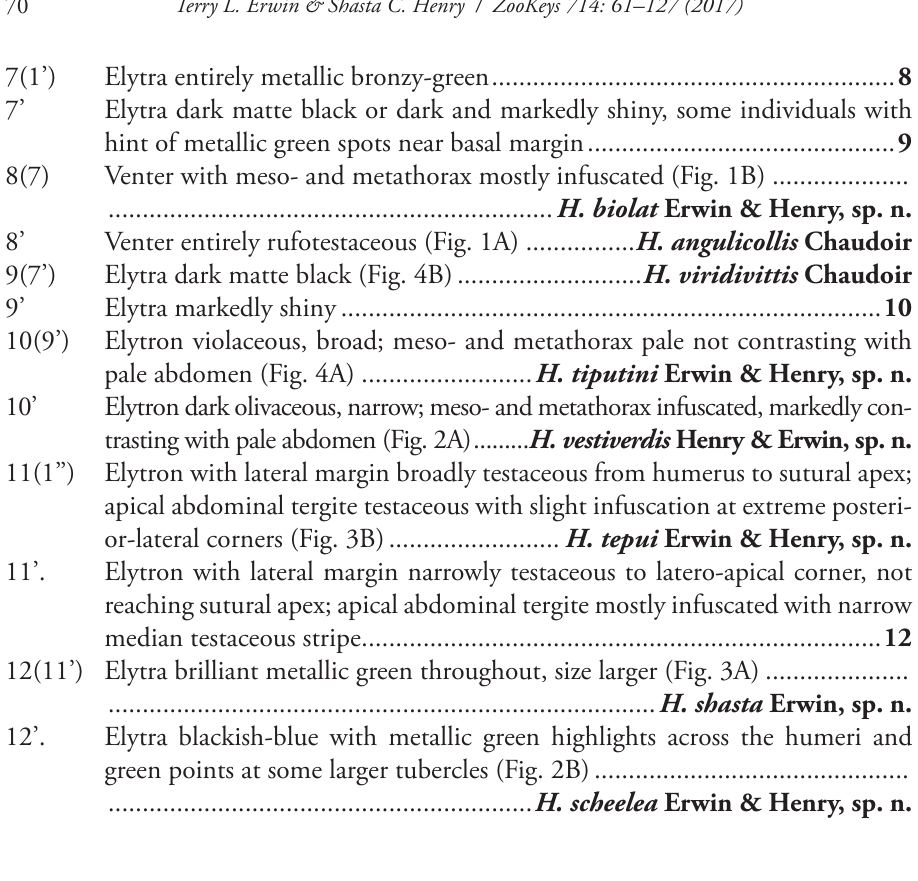
Holotype. Sex unknown. B razil , Amazonas, Ega (Tefé), (HW Bates)(MNHP). Not seen by us; however, we have seen a “homotype” labelled by George E. Ball who stud- ied the holotype in